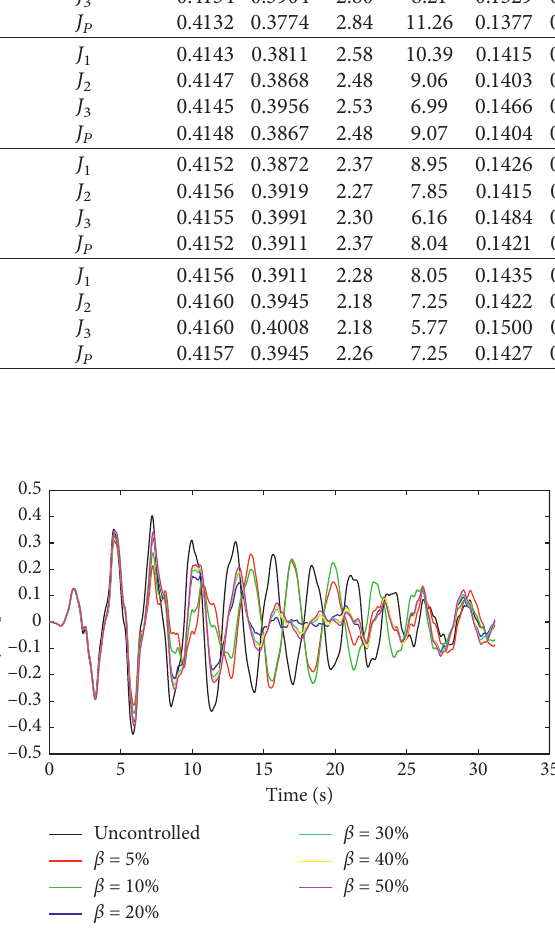
Figure 8: Interstorey drift ratio of the controlled structure sub- jected to “ El Centro ” acceleration record for TMDI designed with µ � 5% and the J P optimization